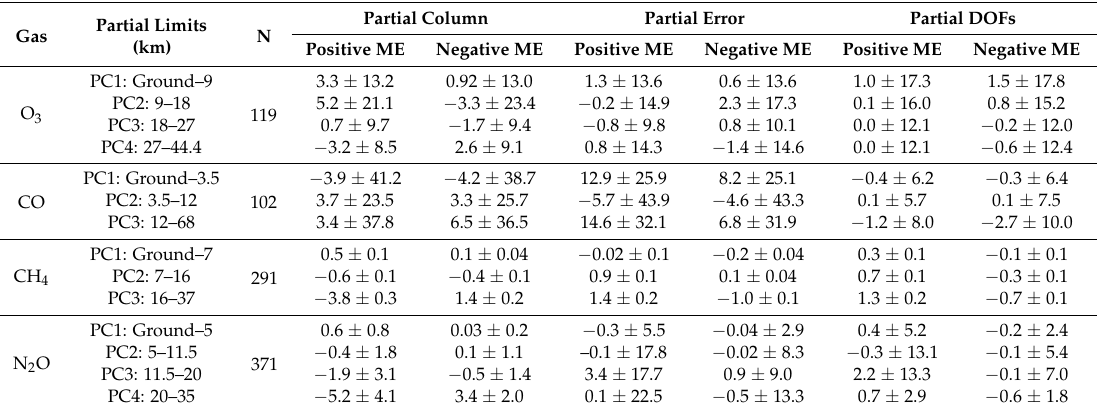
Table 3. The variability (mean ± standard deviation) of fractional differences in the partial column, partial error, and partial DOFs for O 3 , CO, CH 4 , and N 2 O as a function of the solar zenith angle (SZA). Partial Column Partial Error Partial DOFs Partial Limits N Gas (km) Positive ME Negative ME Positive ME Negative ME Positive ME Negative